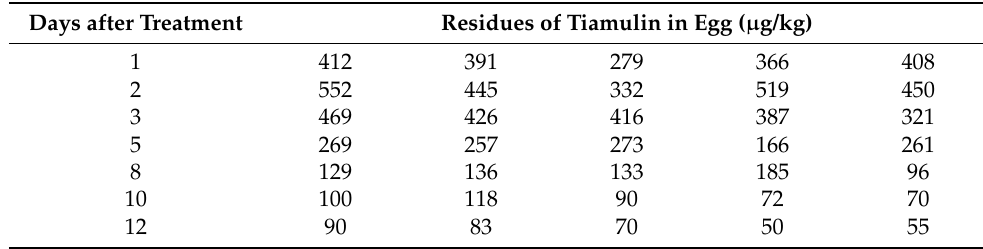
Table 6. Content of tiamulin residues in eggs from laying hens (dose 20,000 µ g THF/kg body weight /day for 7